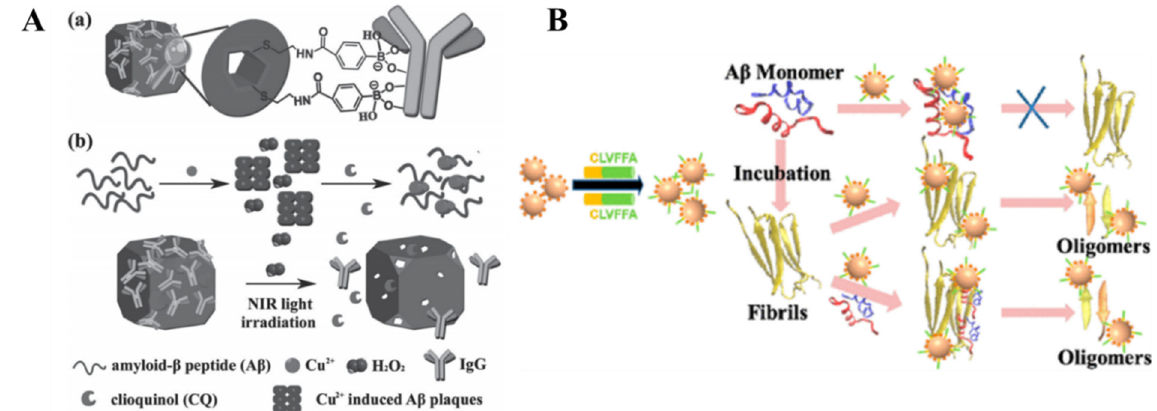
Figure 3. ( A ) (a) Illustration of IgG capped Au nanocages. (b) Schematic representation of H 2 O 2 -triggered and photothermal-responsive release of chelator CQ from IgG capped Au nanocages [64]. Copyright 2013 Wiley-VCH. ( B ) Schematic of CLVFFA-functionalized AuNCs for the inhibition of A β fibrillation. Reprinted with permission from reference [65]. Copyright 2019 American Chemical Society.